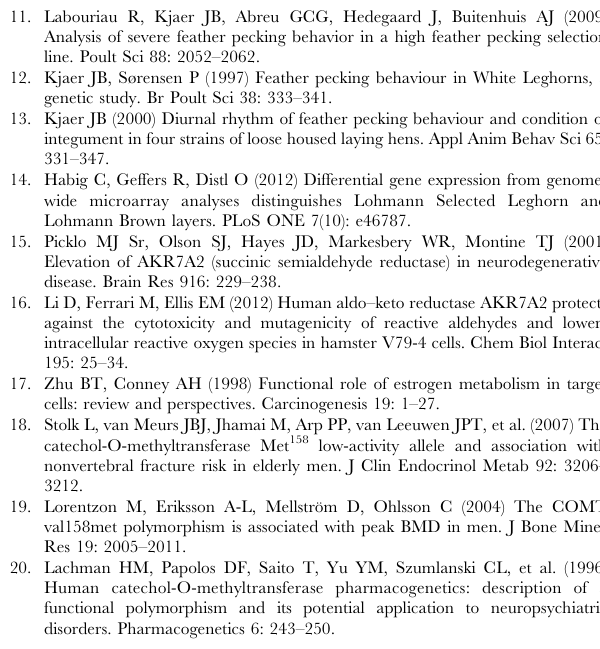
Figure S1 Heat map of differentially expressed probe sets among the two layer lines. Heat map of the probe sets with absolute fold changes of 2-fold or greater detected in the comparison between the layer lines Lohmann Brown (LB) and Lohmann Selected Leghorn (LSL). The range of relative expression levels from lowest to highest is represented by the blue and red dyeing, respectively. Figure S2 Tree graph of the enriched Gene ontology (GO) terms of the biological process category among the list of probe sets with higher expression in LSL (GOEAST, http://omicslab.genetics.ac.cn/GOEAST ). The tree graph displays the hirachial relationships of biological processes identified to be enriched among the list of probe sets with given gene symbol that were significantly up-regulated in the layer line LSL. Significantly enriched GO terms are marked yellow. GO terms without significance are either shown as white boxes or drawn as points. Relationship between two enriched GO terms are marked with red edges, black solid edges stand for relationship between enriched and unenriched terms, black dashed edges stand for relationship between two unenriched GO terms. Each box represents a GO term, labeled by its GOID, the term definition, the P-value and detail informations. Figure S3 Tree graph of the enriched Gene ontology (GO) terms of the biological process category among the list of down-regulated probe sets in LSL (GOEAST, http://omicslab.genetics.ac.cn/GOEAST ). The tree graph displays the hirachial relationships of biological processes identi- fied to be enriched among the list of probe sets with given gene symbol that were significantly up-regulated in the layer line LSL. Significantly enriched GO terms are marked yellow. GO terms without significance are either shown as white boxes or drawn as points. Relationship between two enriched GO terms are marked with red edges, black solid edges stand for relationship between